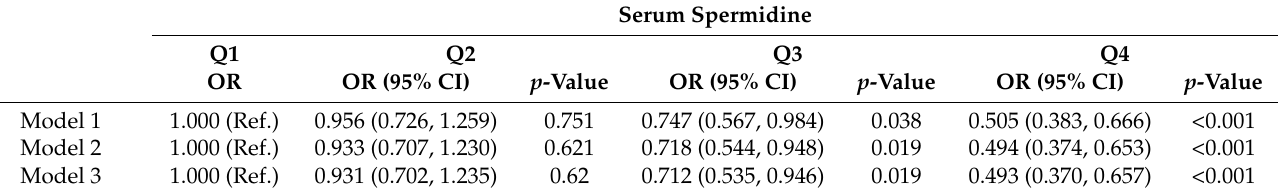
CI: indicates confidence interval; OR: odds ratio. Model 1: adjusting baseline body mass index. Model 2: adjusting gender, age, baseline body mass index. Model 3: adjusting gender, age, baseline body mass index, smoking, drinking, ethnicity, physical labor levels, fruit/vegetables intake levels, whole grain intake levels, triglyceride, HDL-C, LDL-C, total cholesterol, history of diabetes, history of stroke. Restricted cubic spline showed a dose-response relationship between baseline serum spermidine (as a continuous variable) and the change in BMI ( p < 0.001 for the nonlinear